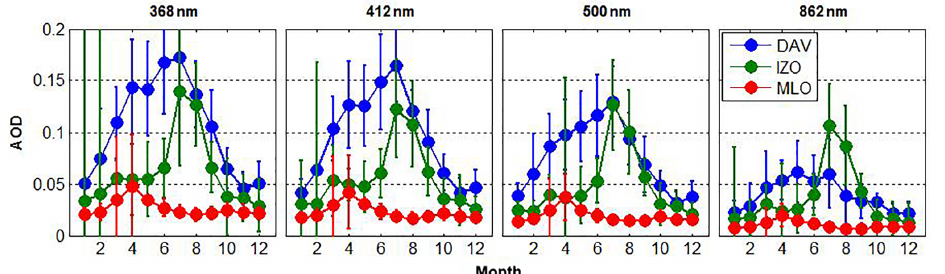
Figure 11. Monthly means and 1 σ standard deviations for Davos, Izaña and Mauna Loa using 15 years of 1min quality-controlled PFR measurements at four